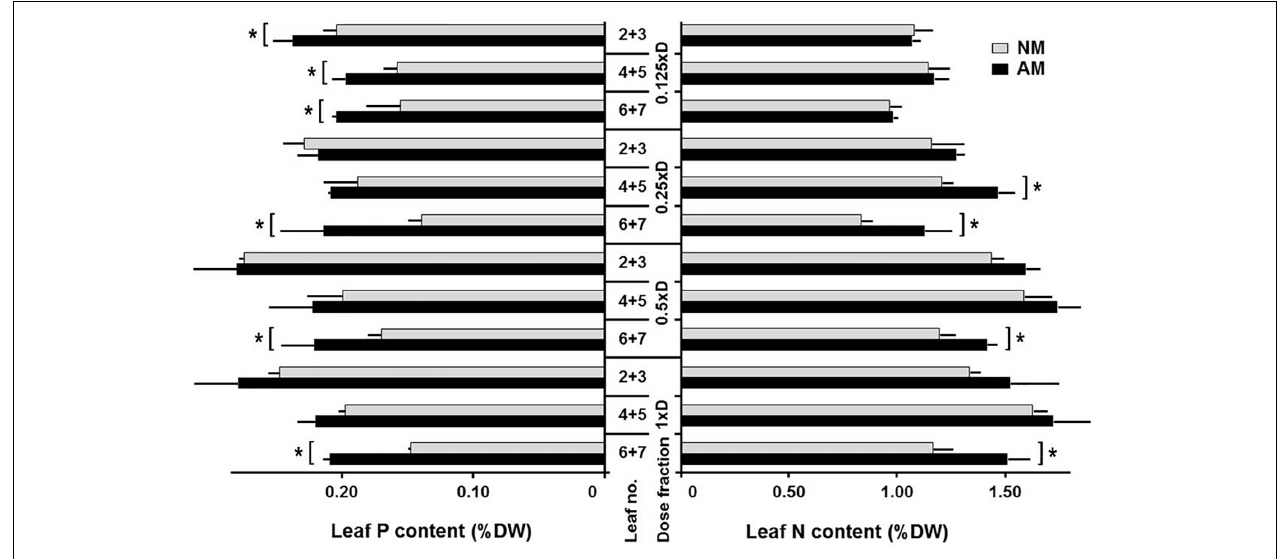
FIGURE 1 | Effect of mycorrizae and fertilization level0 on nitrogen (N) and phosphorus (P) accumulation in leaves at three vertical canopy positions. P and N content of non-mycorrhized (NM) and mycorrhized (AM) plants, grown at four fertilization levels (0.125xD, 0.25xD, 0.5xD, 1xD). The data represent averaged values ( n = 4), taken as mixed samples from two adjacent leaves (joined leaf numbers: L2+3, L4+5, and L6+7), representing four plants for each fertilization and symbiotic variant The measurements were made at the time of tasseling (10 weeks after sowing), after 4 weeks fertilization with one of four fertilizer dilution. The minerals content was expressed as weight units per leaf dry mass (g 100g − 1 ). Asterisks represent statistical significance between NM and NM means according to t -Student test at p < 0.05.